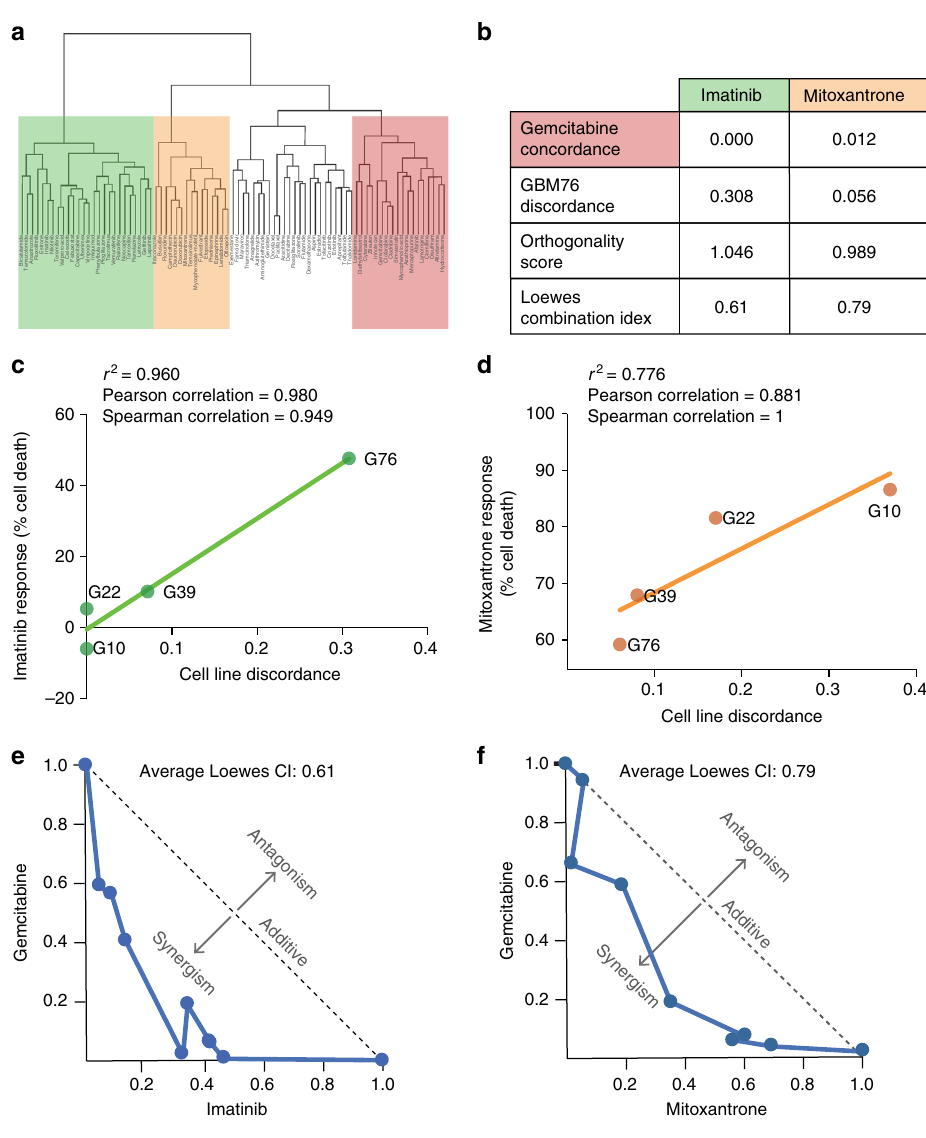
Fig. 7 Combining FDA-approved compounds induces synergy in reducing GBM cell proliferation. L1000 pro fi ling was performed for 83 FDA-approved compounds. a Compounds were clustered according to the transcriptional pro fi le they induce in all cancer cells. Group 1, shaded in green, contains imatinib; Group 2, shaded in orange, contains mitoxantrone, and Group 3, shaded in red, contains gemcitabine. b Compounds were ranked based on concordance to gemcitabine and discordance from signature of the mean of the PDX GBM cell lines and two compounds were selected to test for proof of concept: imatinib and mitoxantrone. Orthogonality score was computed and the Loewes combination index was calculated in PDX GBM76 cells. c , d The reduced cell proliferation responses to imatinib and mitoxantrone in monotherapy for 4 cell lines were plotted against the cell line-speci fi c discordance scores for imatinib ( c ) or mitoxantrone ( d ). e , f Combinations were tested in PDX GBM76 cells. Synergy was calculated using the Loewe additive model and a normalized isobologram was plotted to visualize synergy for each combination. Source data can be found in the Source Data fi le, Supplementary Data